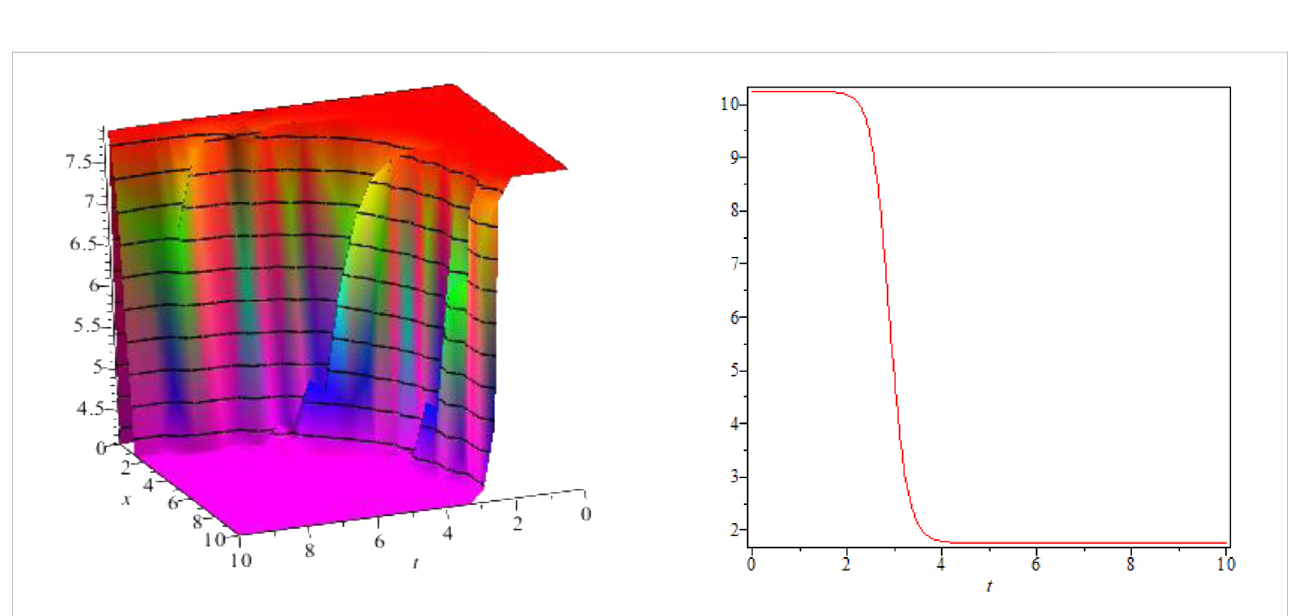
, k (cid:2) 2 , a (cid:2) 1 , a (cid:2) − 1 , γ ( x , t ) (cid:2) 2cos ( xt )+( xt ) 0 1 2 2